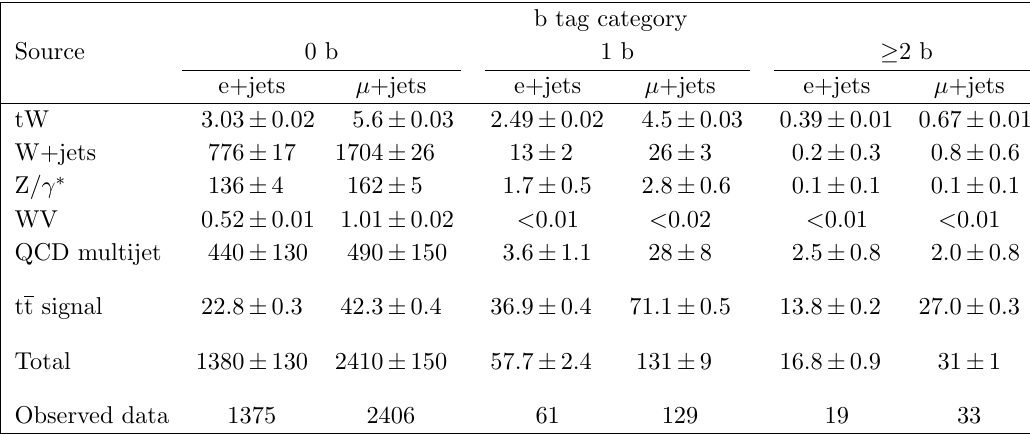
Table 1 . The number of expected background and signal events and the observed event yields in the di(cid:11)erent b tag categories for the e+jets and (cid:22) +jets analyses, prior to the (cid:12)t. With the exception of the QCD multijet estimate, for which the total uncertainty is reported, the uncertainties re(cid:13)ect the statistical uncertainty in the simulated samples.